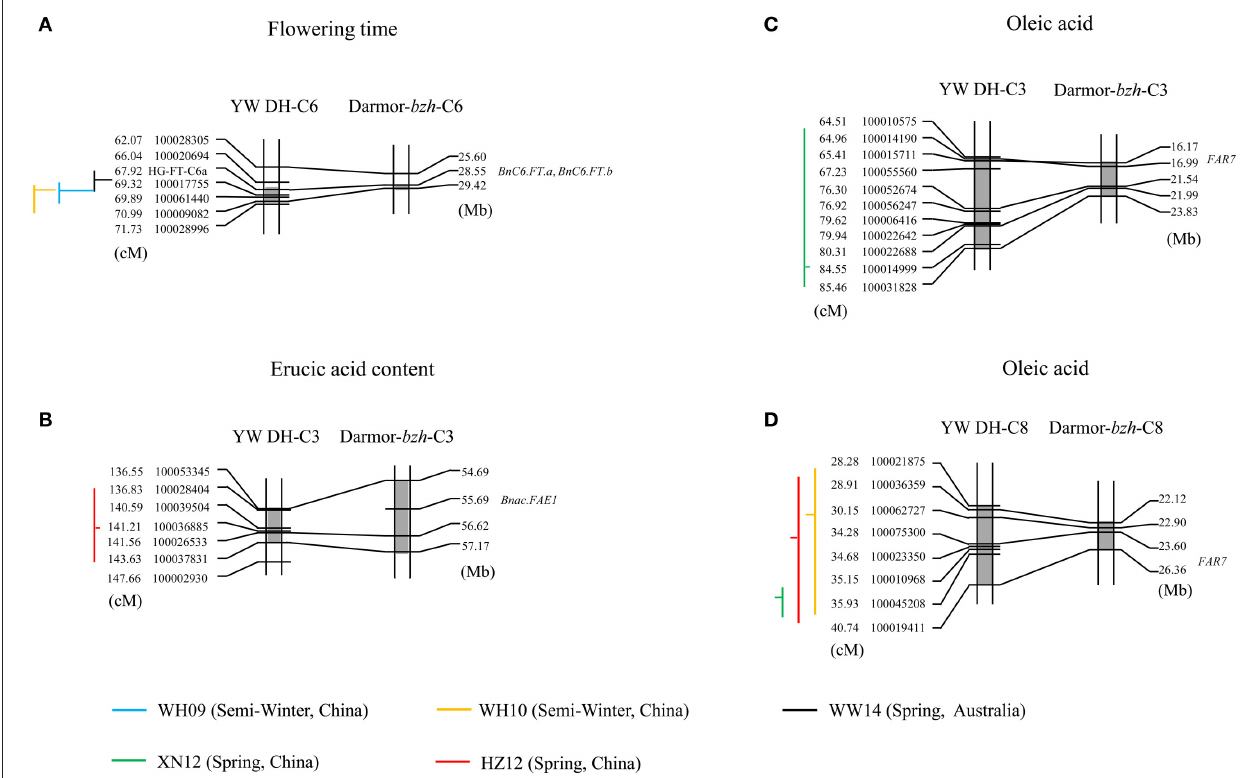
FIGURE 8 | The QTL regions identified in C genome of YW DH population and the physical position of genes in Darmor- bzh ( B. napus ). (A,B) represent the alignment of the QTL for flowering time in chromosome C6 and erucic acid in chromosome C3, respectively. (C,D) represent the alignment of the QTL for oleic acid in chromosome C3 and C8, respectively. The lines with blue, yellow, black, green, and red represent the QTL in the experiments of WH09, WH10, WW14, XN12, and HZ12, respectively. The gray shadow box showed the QTL region in the chromosomes. The vertical lines and horizontal lines represent the confidence interval and the peak position of QTL, respectively. The horizontal lines located to the right of the vertical lines means the negative additive effect. The parent W-BcDH76 contributes the positive effect in the YW DH population.